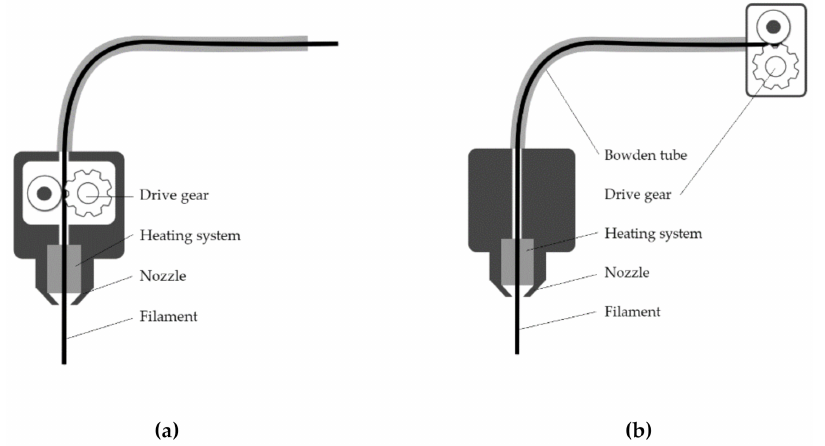
Figure 12. Two types of extruder head configurations: ( a ) a direct drive extruder, with both gear drive and heating system are mounted on the extruder head, and ( b ) Bowden drive, with the drive gear placed outside the extruder